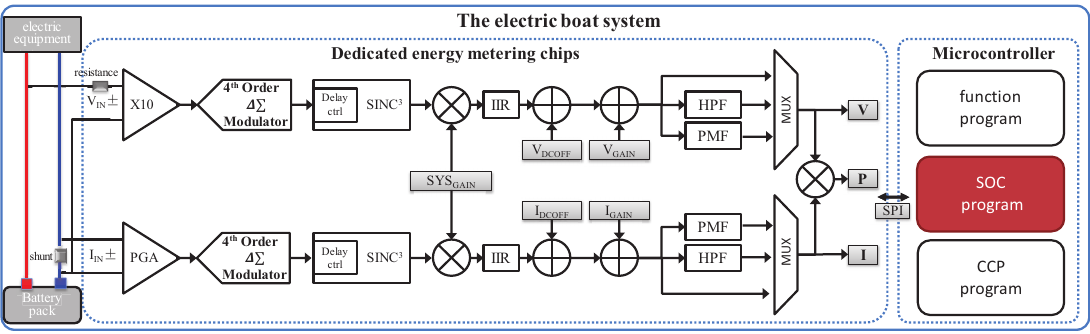
Figure 3. Energy metering hardware structure of